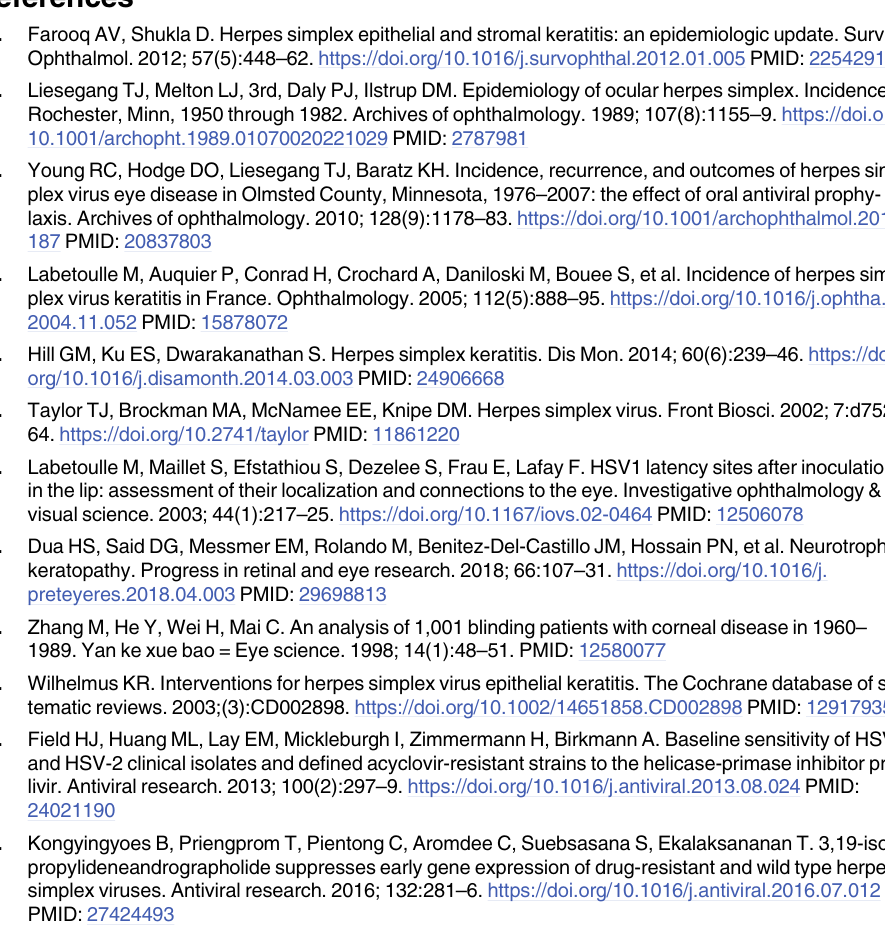
S1 Table. Primary antibodies used for immunostaining on flat-mounted corneas and on cross-sections. S2 Table. Characteristics of the pairs of corneas, and main results